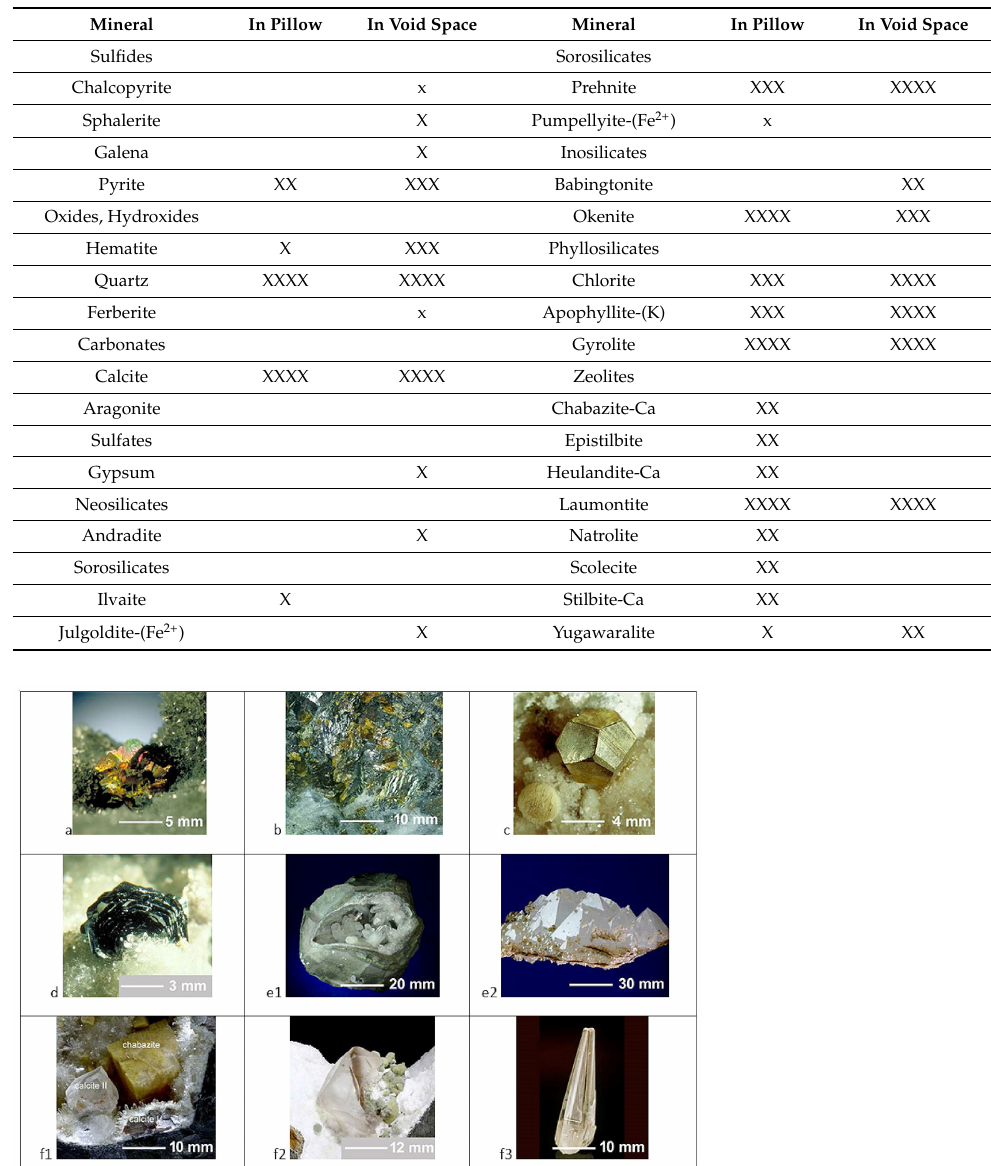
Table 1. Frequency of the secondary minerals from the cavities and void spaces from Salsette Island. X—very rare, XX—rare, XXX—frequent, XXXX—common.